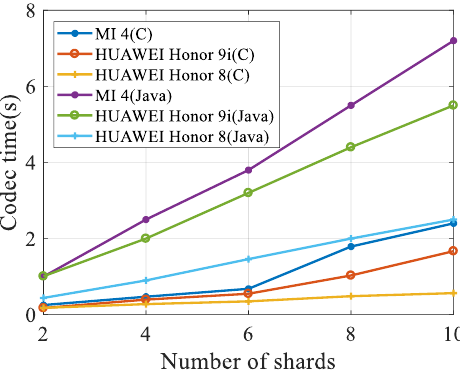
Figure 3. Encoding Efficiency in Different Mobile Devices.